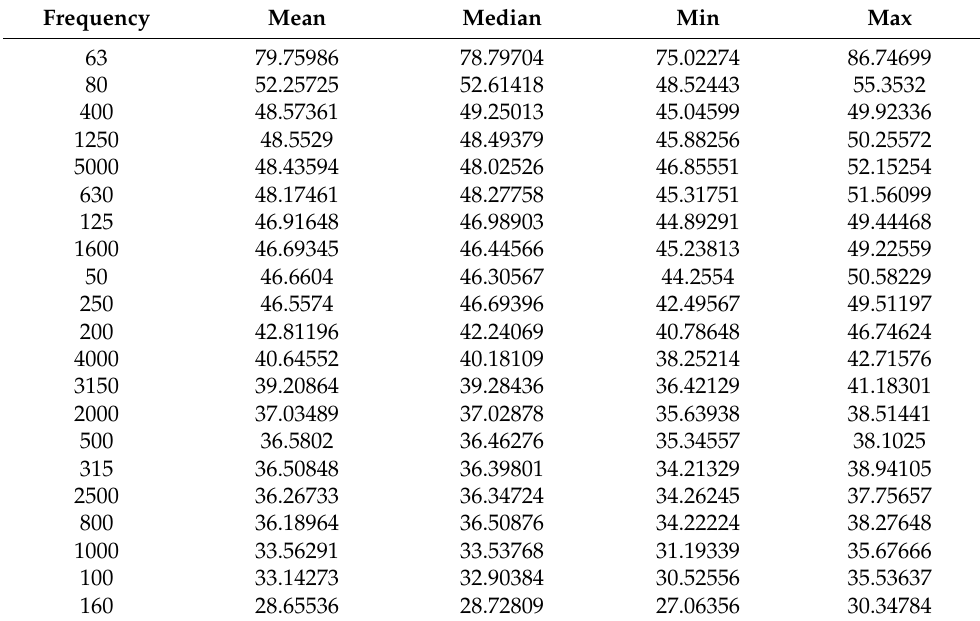
Table 2. Attribute statistics of the feature selection analysis related to the importance of the one-third frequency components, sorted by mean value (Figure